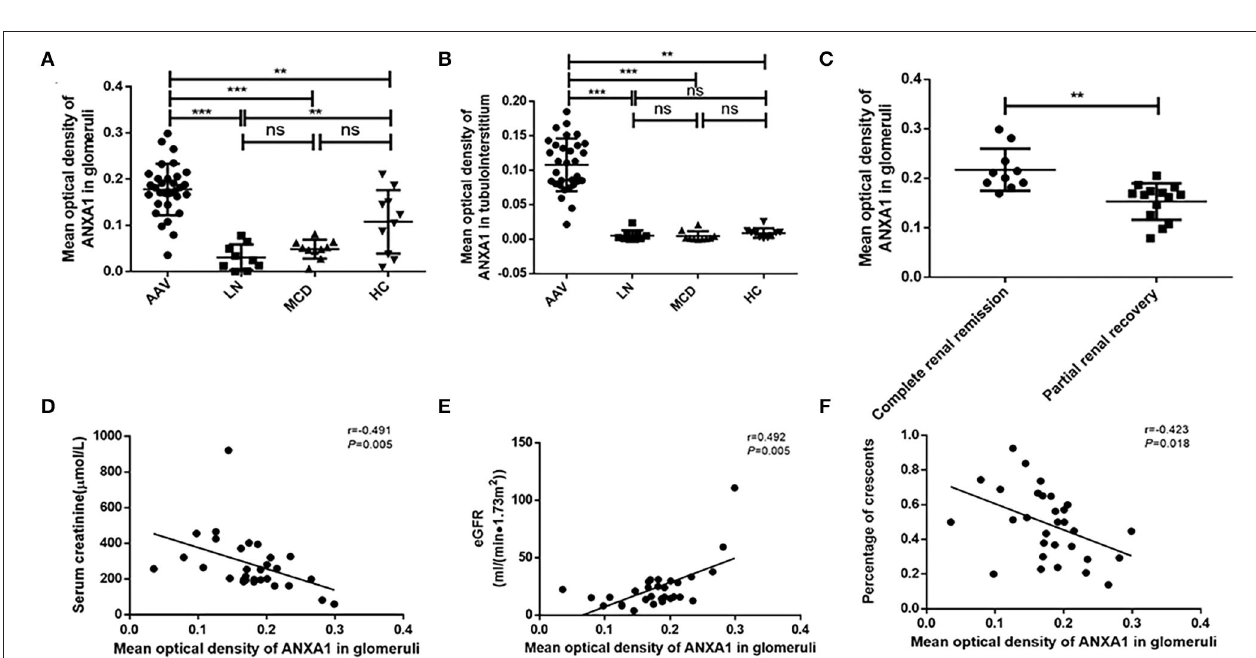
FIGURE 4 | (A) Mean optical density of ANXA1 in glomeruli of AAV patients, LN, MCD and healthy controls respectively. (B) Mean optical density of ANXA1 in tubulointerstitium of AAV patients, LN, MCD and healthy controls respectively. (C) Comparison of ANXA1 expression of patients achieving complete renal recovery with those achieving partial renal recovery. (D–F) Correlation analyses of ANXA1 expression in glomeruli of AAV patients with serum creatinine (D) , eGFR (E) and the proportion of crescents (F) , respectively. AAV, anti-neutrophil cytoplasmic antibody (ANCA)-associated vasculitis; ANXA1, annexin A1; eGFR, estimated glomerular filtration rate; HC, healthy control; LN, lupus nephritis; MCD, minimal change disease; ns, no significance ( P > 0.05). ** P < 0.01, *** P < 0.001.